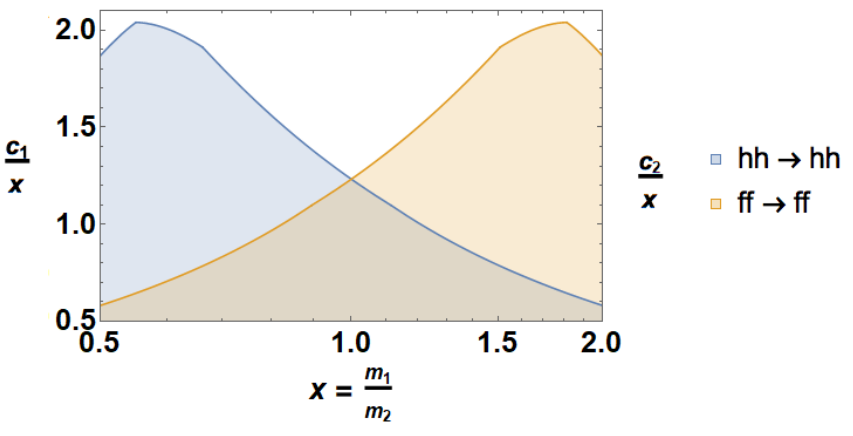
Figure 3 . The allowed values of the cubic couplings, c 1 (blue) and c 2 (yellow), as a function of the mass ratio, x , obtained from hh ! hh scattering. For a given value of x , the maximal allowed value, c 1 = c 1max , is determined as the value at which the allowed ( c 3 ; d 5 ) island shrinks to a point.